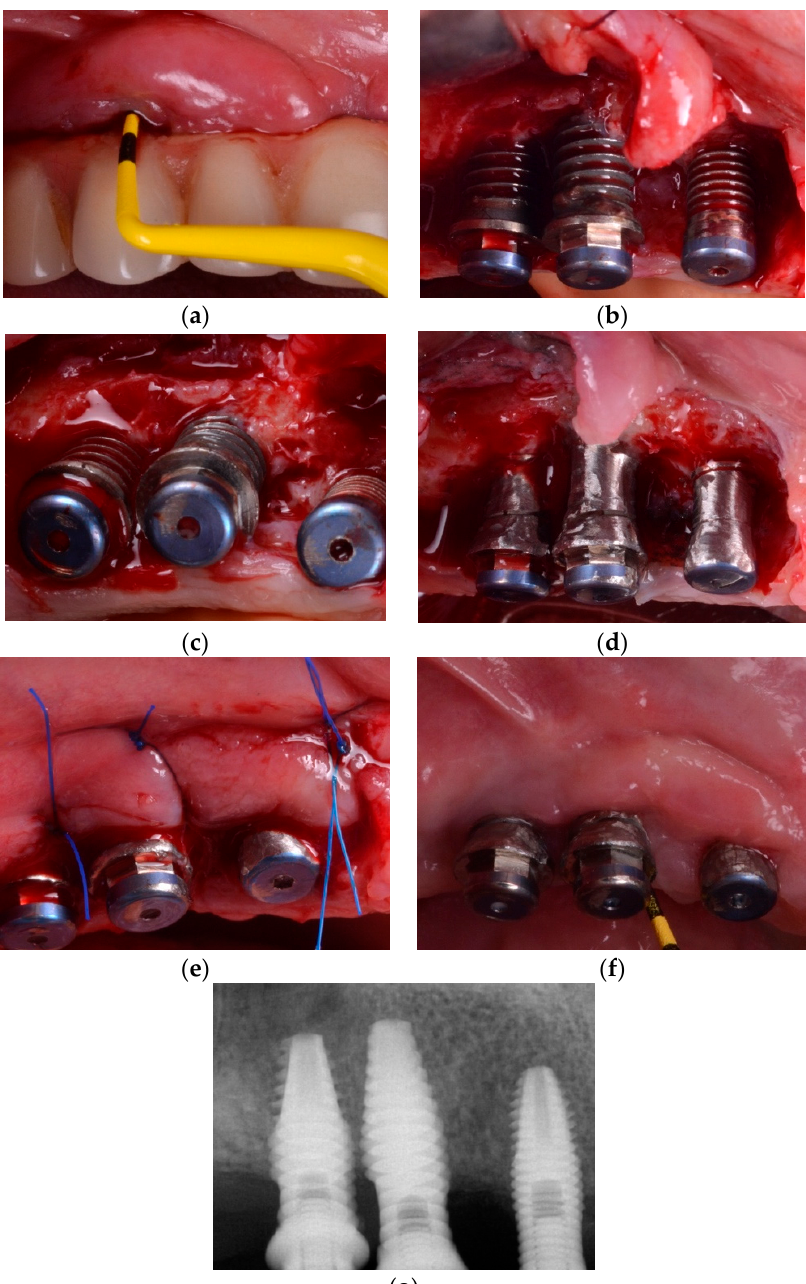
Figure 4. ( a ) Clinical presentation of peri-implantitis; ( b ) Access flap reveals moderate bone loss (<50%) (frontal view). Note the supra-crestal defect morphology; ( c ) Occlusal view of moderate bone loss; ( d ) Implantoplasty was performed as adjunct to the surgical resective therapy of peri-implantitis (frontal view); ( e ) Occlusal view of the implantoplasty and bone topography after osteoplasty to reach a flat bone architecture; ( f ) clinical resolution of peri-implantitis at 6-month follow-up; ( g ) bone stability is noted upon radiographic assessment.